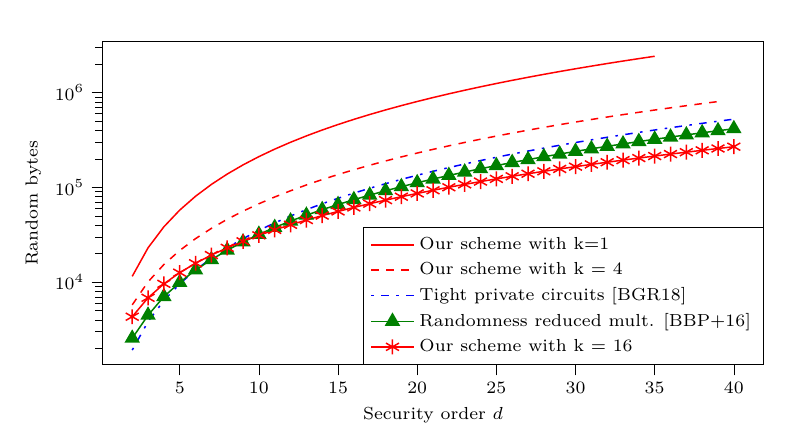
Figure 6: Randomness cost comparison with state-of-the-art based on masked AES-128. In total, this implementation of a masked AES round function requires 4(16 /k )2 nm + 3(16 /k ) nm + 16 nm/k = 192 nm/k random bytes. Considering d = m , our masked